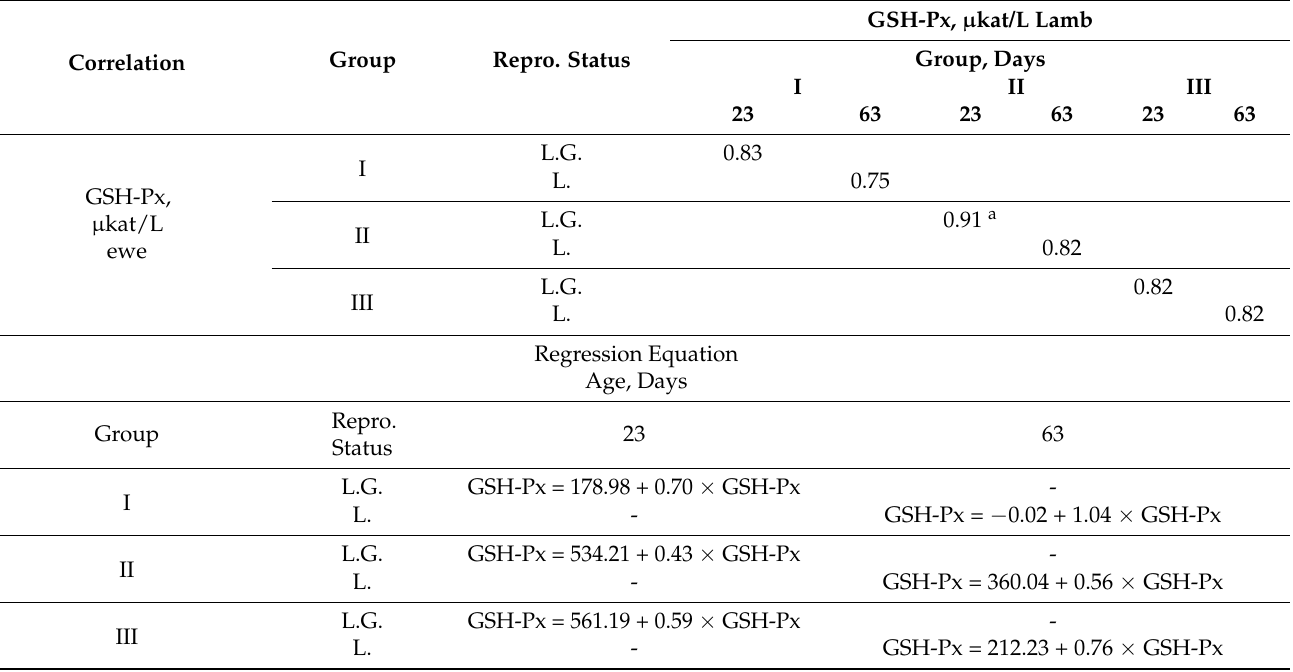
Table 6. Correlation coefficients and regression equations between the activities of GSH-Px in the blood of ewes and lambs.